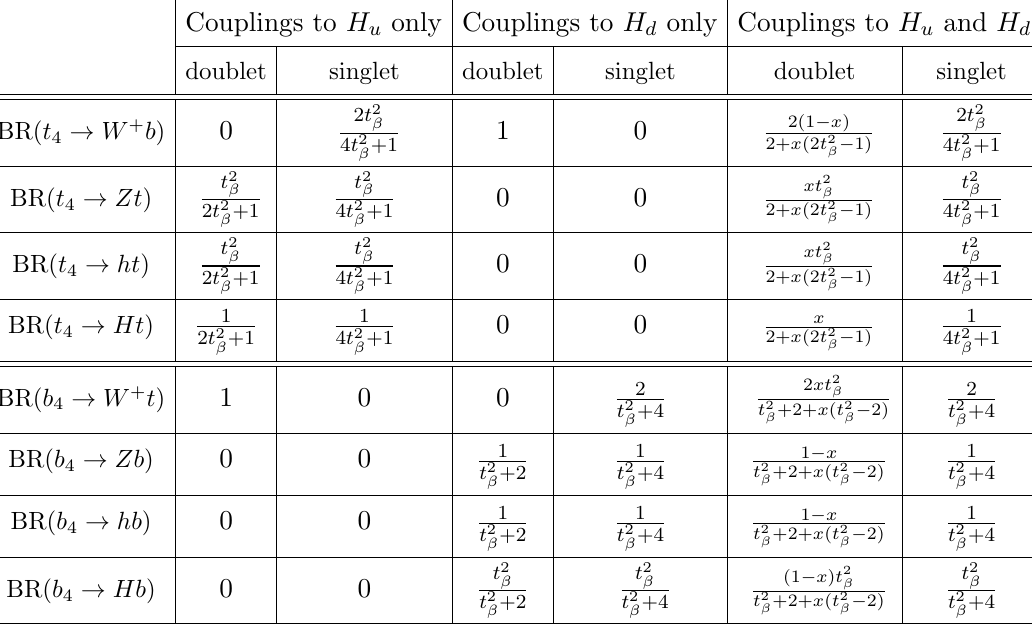
Table 4 . Branching ratios of the vectorlike quarks t 4 and b 4 into W , Z , h and H as a function of t (cid:12) = tan (cid:12) and x = (cid:20) 2 = ( (cid:20) 2 + (cid:21) 2 ). These expressions are an excellent approximation for heavy Q Q Q vectorlike masses and in the limit in which the couplings in table 2 dominate.